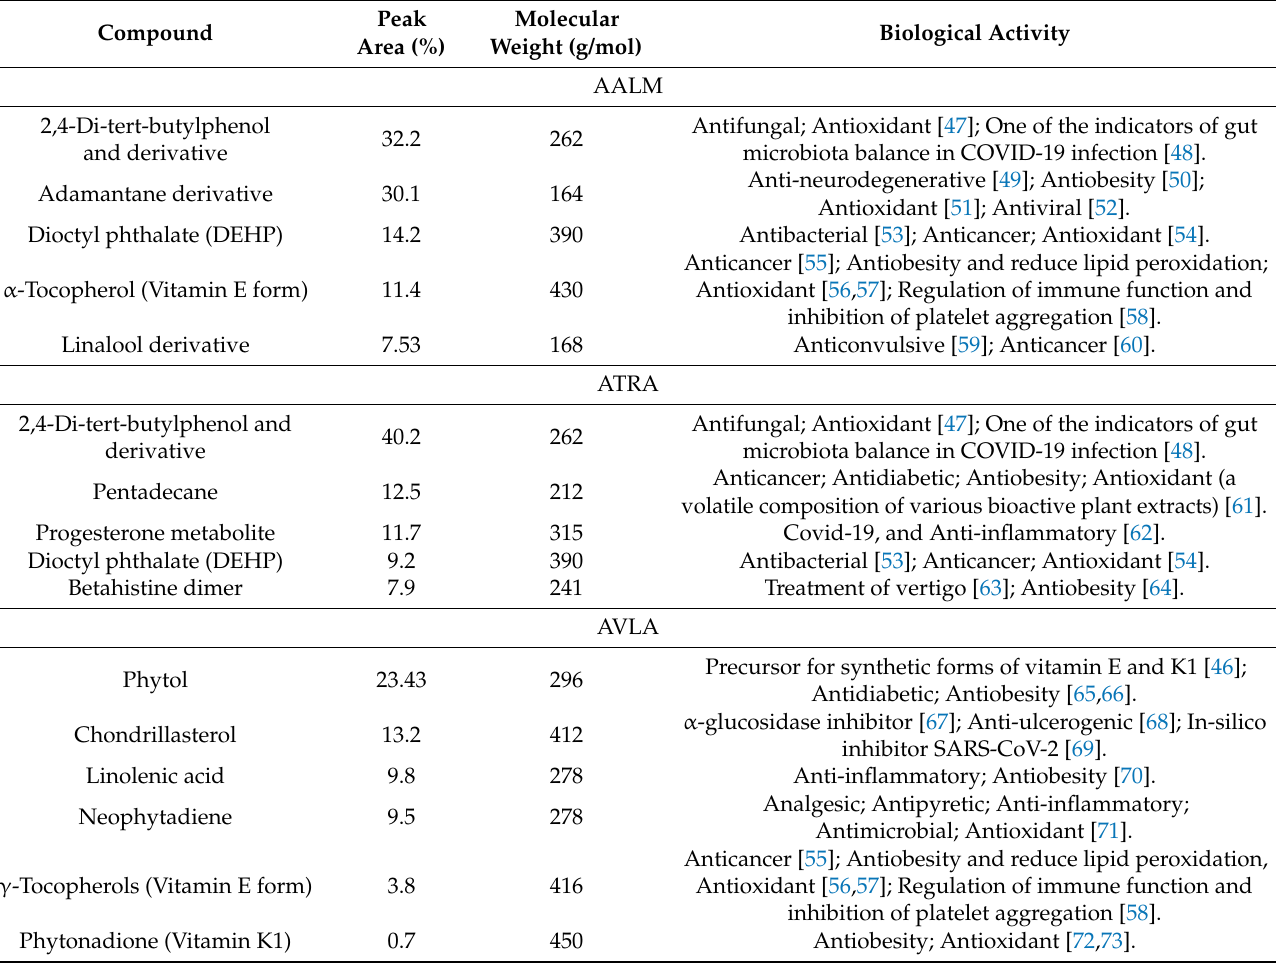
Table 3. Biologically active compounds identified in GC-MS analyses of AALM, ATRA, and AVLA extracts.